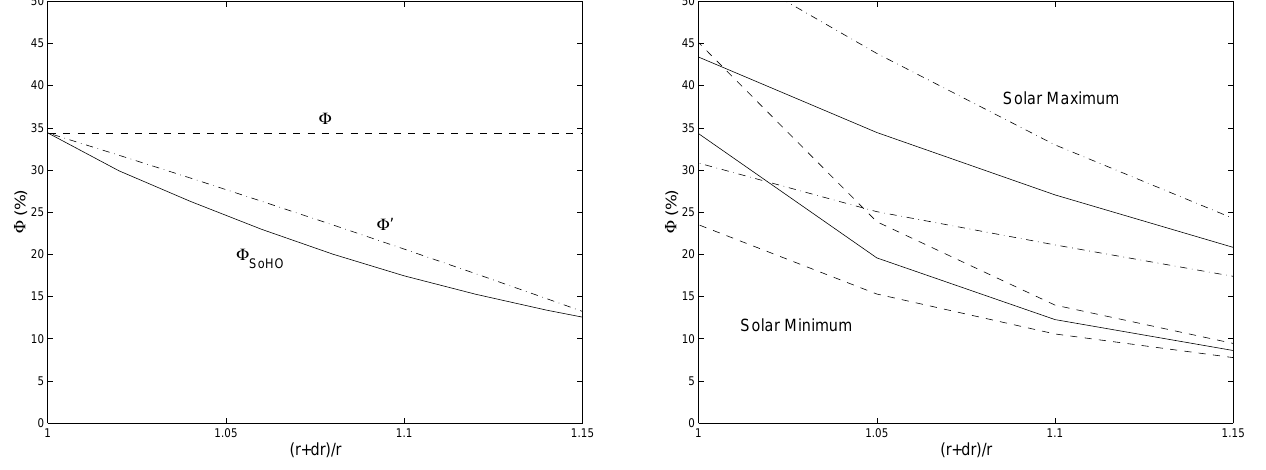
Fig. 2. A comparison of three functions describing the variation of the unobscurred ionising radiation, 8 , with the ratio of lunar and solar radii, (r + dr)/r . Here the dash-dotted line (labelled 8 0 ) rep- resents 8 values adjusted using a simple geometric correction (as given by Eq. 5). It can be seen that this closely matches the solid line labelled 8 SOHO , which represents the observed variation, as calculated from data from the EIT instrument on SOHO taken dur- ing the eclipse of 11 August 1999. The uncorrected 8 value is also plotted for comparison.